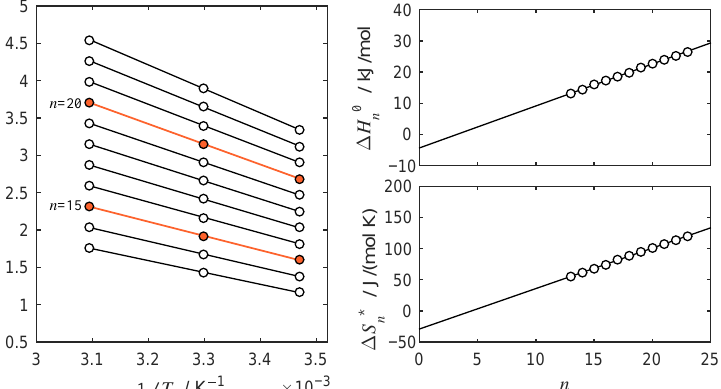
Figure 3. Determination of thermodynamic parameters for the separation of PEG 1000 on the preparative column for the example of an eluent with 17 vol% ACN. ( Left ) van’t Hoff plot of data and linear regression against Equation (1) (lines) for the different homologs. ( Right ) enthalpic and entropic contributions as a function of n corresponding to the slopes ( ∆ H ◦ n ) and intercepts ( ∆ S ∗ n ) of the lines in the left (symbols). Linear regression against Equation (2) (lines) delivers ∆ H ◦ r , ∆ H ◦ e , and ∆ S ∗ ∆ S ∗ r , e as slopes and intercepts, respectively.